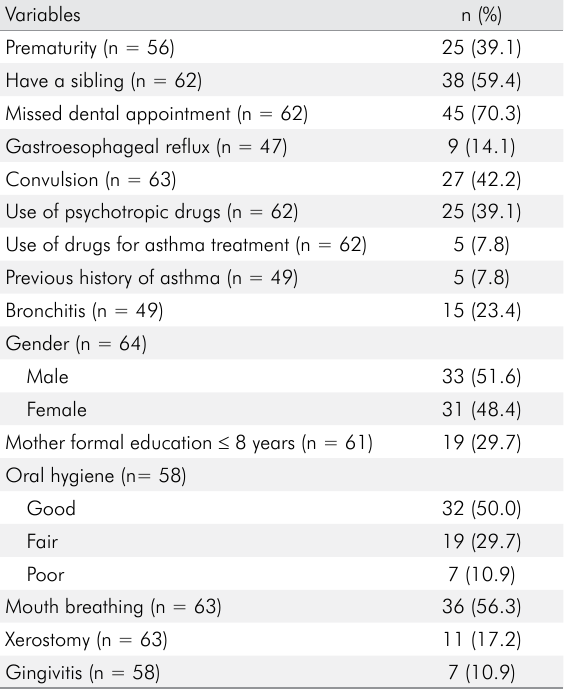
Table 1. Clinical and sociodemographic characteristics of patients with developmental disabilities and with dental caries at the first appointment, age ≥ 5 years in Belo Horizonte, Brazil, from 1998 to